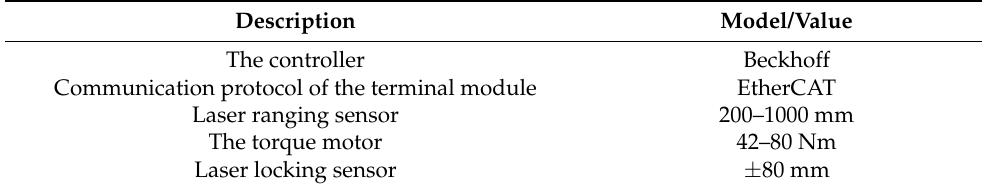
Table 2. Electronic system parameter list.